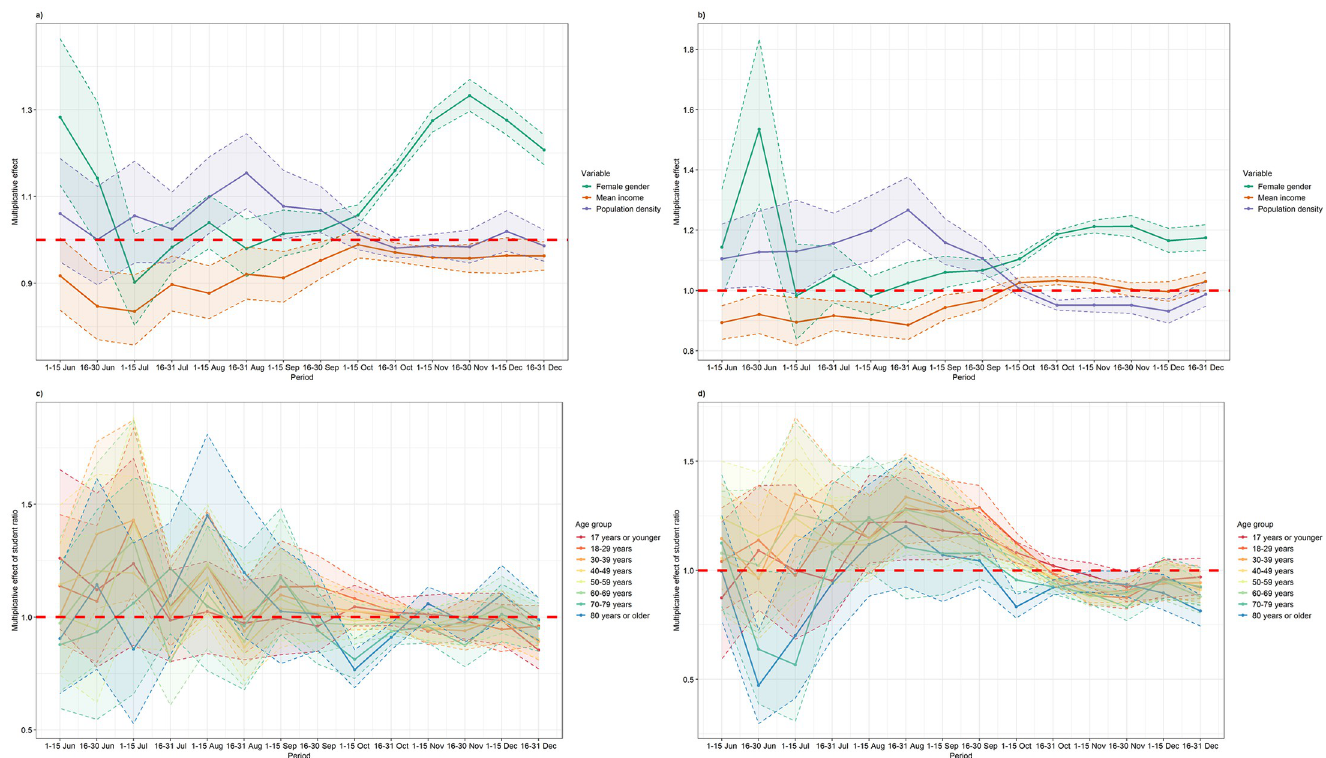
Fig 7. Effect of other covariates. Top: Effect of gender, mean income, and population density to predicted COVID-19 incidence in Flanders (a) and Wallo-Brux (b); Bottom: Multiplicative effect of higher education students to COVID-19 incidence in Flanders (c) and Wallo-Brux (d).